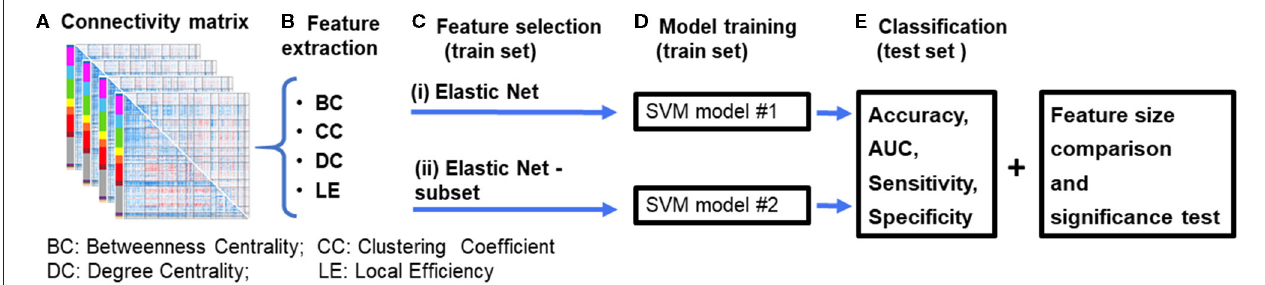
FIGURE 1 | Diagrammatic representation of the data processing pipeline. (A) First, resting-state functional connectivity (rsFC) matrices are computed for each subject. (B) Graph theory features are then extracted from the connectivity matrices. (C) Features were selected using an (i) Elastic Net feature selection method, and (ii) proposed Elastic Net-subset (Elastic Net + optimal subset selection) approach to identify predictive features while reducing feature redundancy. (D) Two SVM models were constructed for each of the feature selection approaches. (E) Each model’s performance (accuracy, AUC, sensitivity, specificity, and the total number of features used in the final model) were computed and then compared between both models. A significance test was performed using a permutation test approach. The whole process was repeated for each feature set and their combinations (for example, BC + CC + DC). BC, Betweenness Centrality; CC, Clustering Coefficient; DC, Degree Centrality; LE, Local